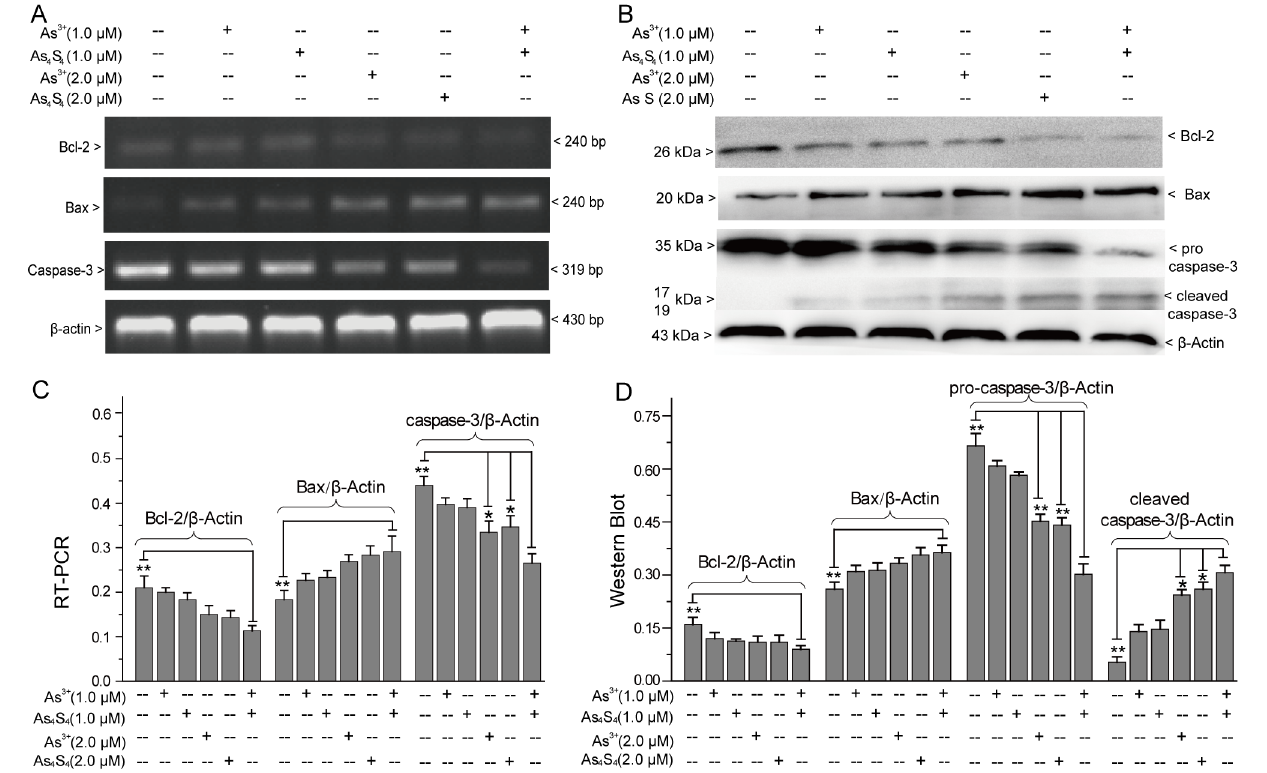
Fig 5. The effects of combining As 4 S 4 and As 3+ on mitochondria-mediated apoptosis. (A) RT-PCR analysis of Bax, Bcl-2 and caspase-3 expression. (B) Western-blot analysis of Bax, Bcl-2 and caspase-3 expression. (C) Relative intensity of expression obtained by RT-PCR. (D) Relative intensity expression obtained by western-blot. Error bars represent the S.D. from the mean of three separate experiments. * P < 0.05 and ** P < 0.01 compared with As 3+ and As 4 S 4 combination treated